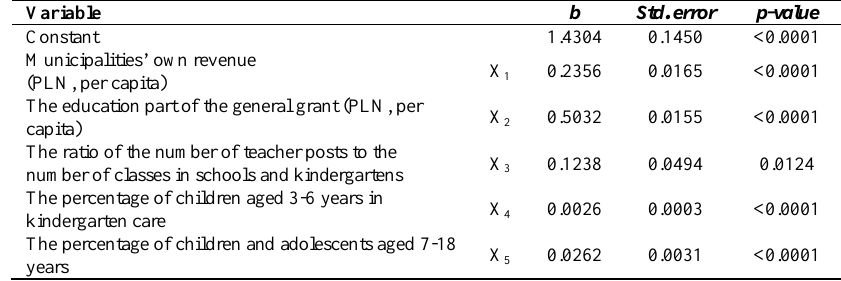
Table 3. The regression results for education expenditures in municipalities with the highest own revenue per capita in 2016 (N=843)